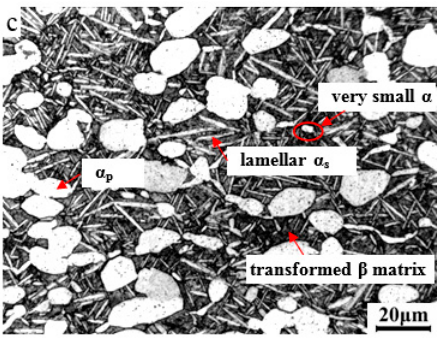
Figure 3. Optical micrographs of TA15 alloy after near- β forging and solution + aging treatment: ( a ) 970 °C/0.1 s − 1 /65%/WQ + 930 °C/1 h/AC + 550/5 h/AC; ( b ) 970 °C/0.1 s − 1 /60%/(AC + WQ) + 930 °C/1 h/AC + 550 °C/5 h/AC; ( c ) 970 °C/0.1 s − 1 /60%/(AC + WQ) + 930 °C/1 h/AC.